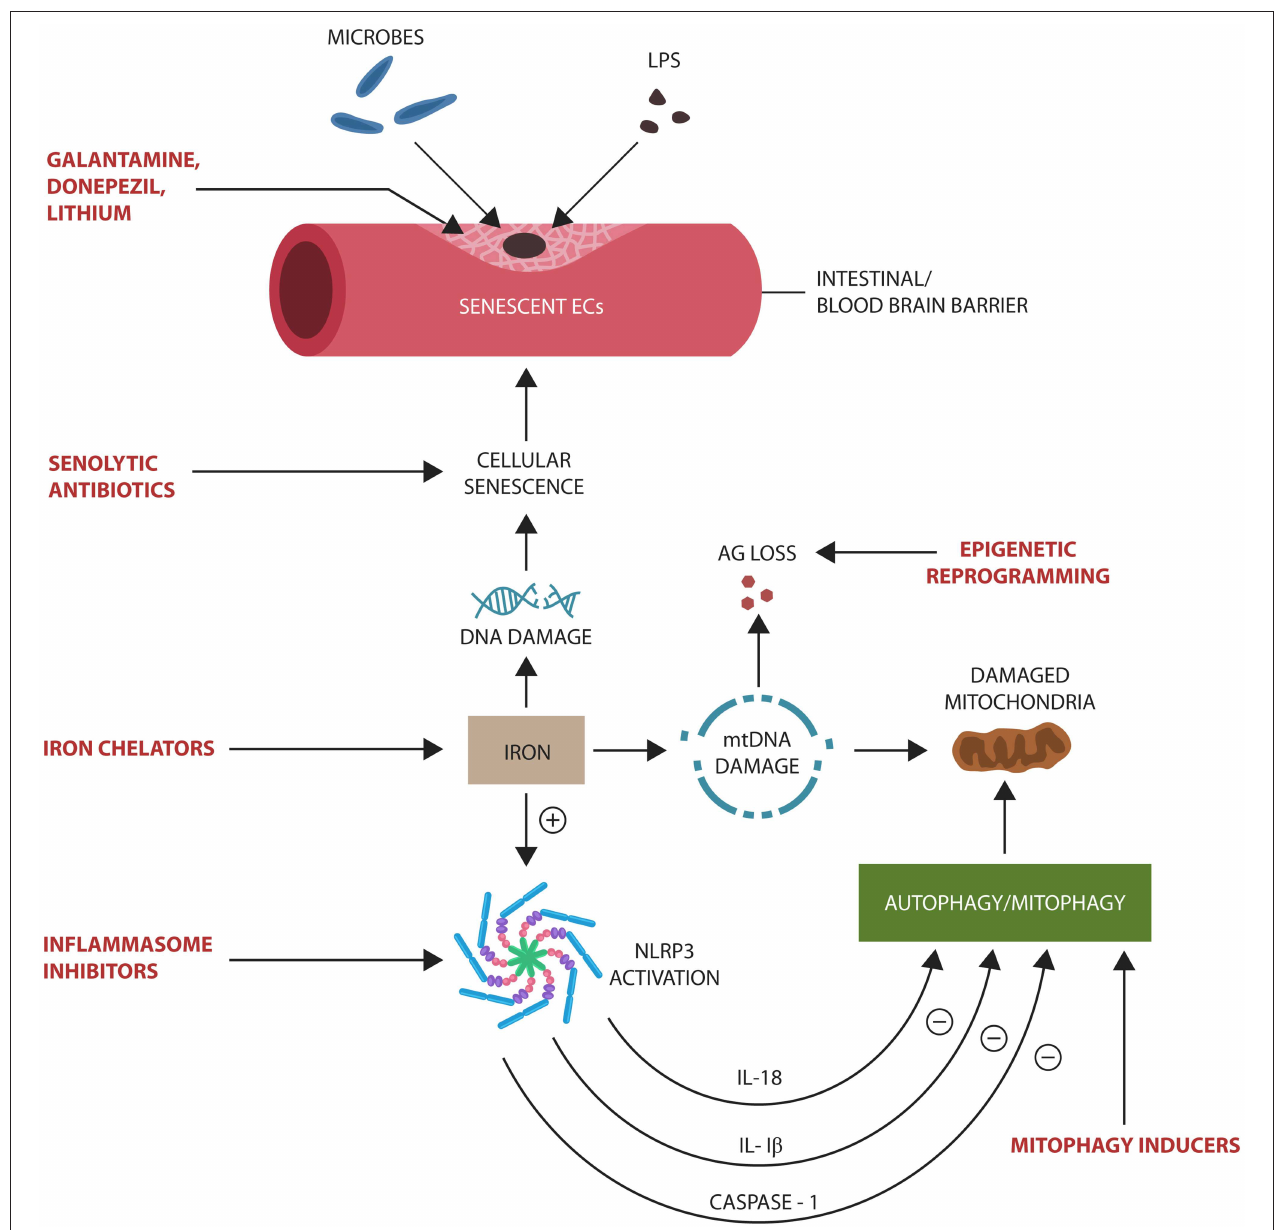
FIGURE 4 | Potential senotherapeutic interventions in AD and the steps at which they may operate. NLRP3 end products, IL-1 β , IL-18, and caspase-1, inhibit autophagy and mitophagy, contributing to the accumulation of senescent cells and damaged mitochondria. These, in turn, alter biological barriers, enabling microbial translocation and AG loss. Excess iron induces DNA and mtDNA damage, activating NLRP3 with subsequent cellular senescence.